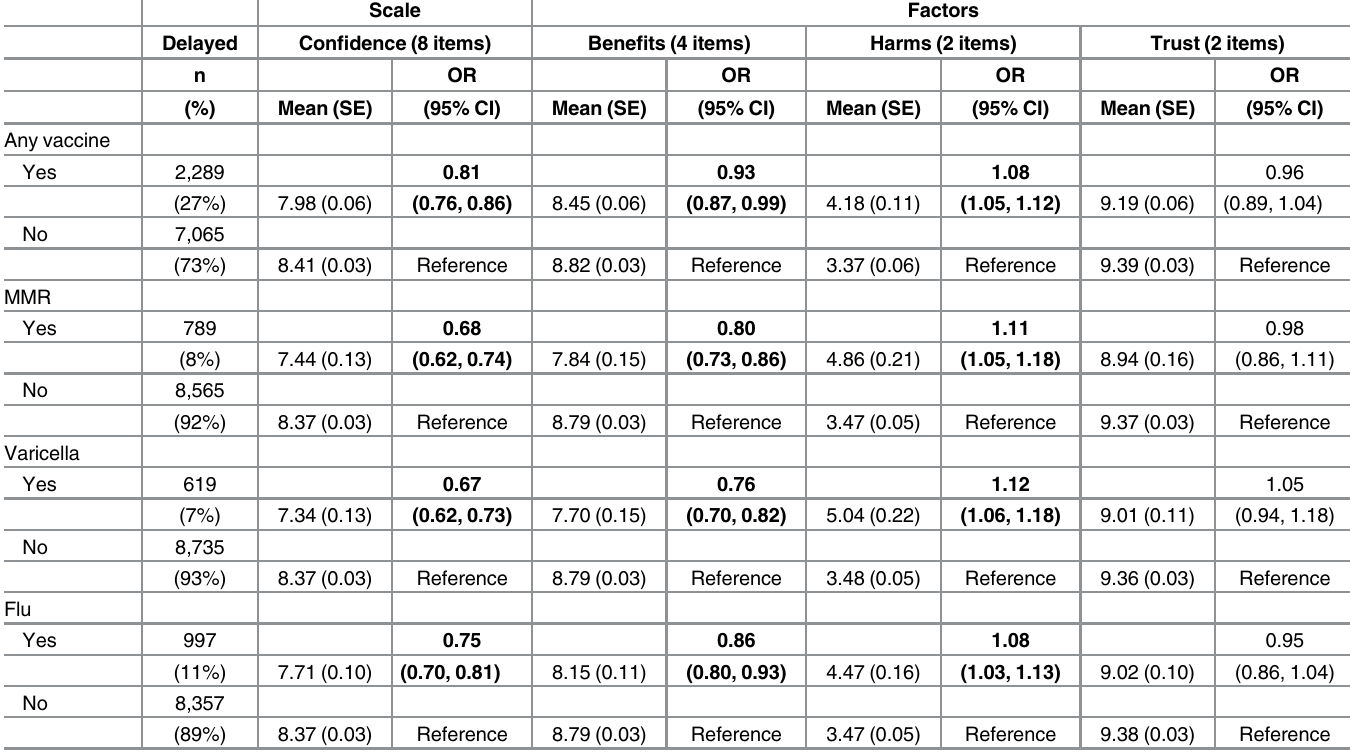
Table 3. Parent-reported vaccine delay: Multivariable associations with scale and factor score means ( n = 9,354).